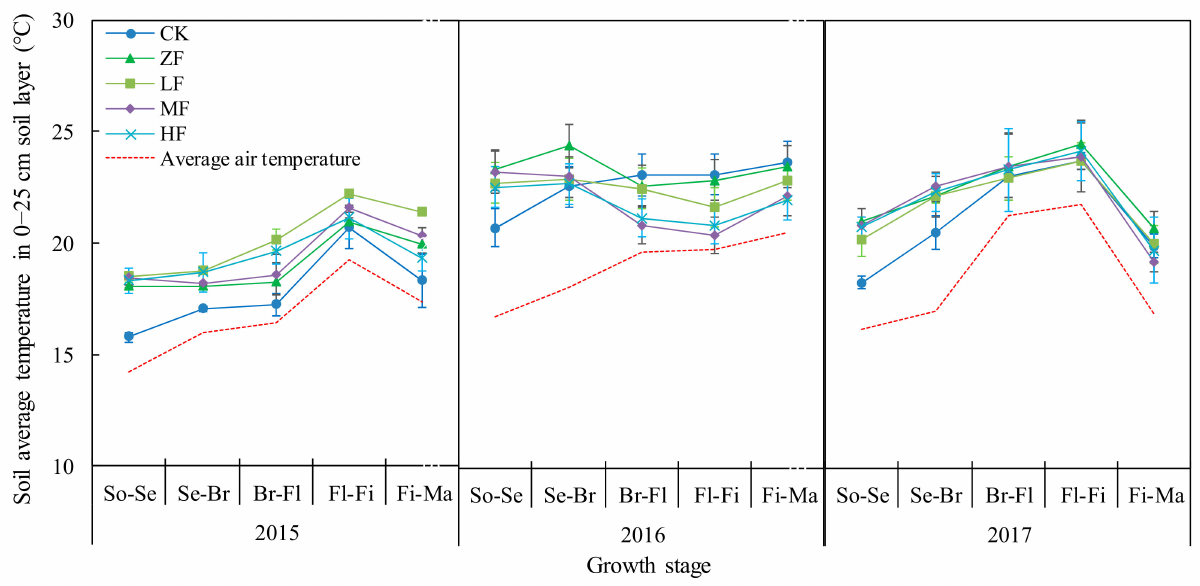
Figure 3. Dynamics of average soil temperature (T s , ◦ C) in 0–25 cm soil layer during the growing seasons of tartary buckwheat in 2015–2017. HF: high fertilization level; MF: moderate fertiliza- tion level; LF: low fertilization level; ZF: zero fertilization; CK: the control with no mulching and zero fertilization. So–Se: sowing–seeding; Se–Br: seeding–branching; Br–Fl: branching–flowering; Fl–Fi: flowering–filling; Fi–Ma: filling–maturity. Bars are error bars of the means (n =